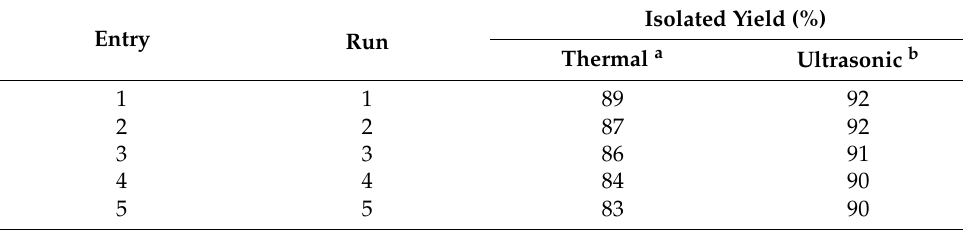
Table 3. The effect of reusability of SPION@CS-IL on the product 4g yield.